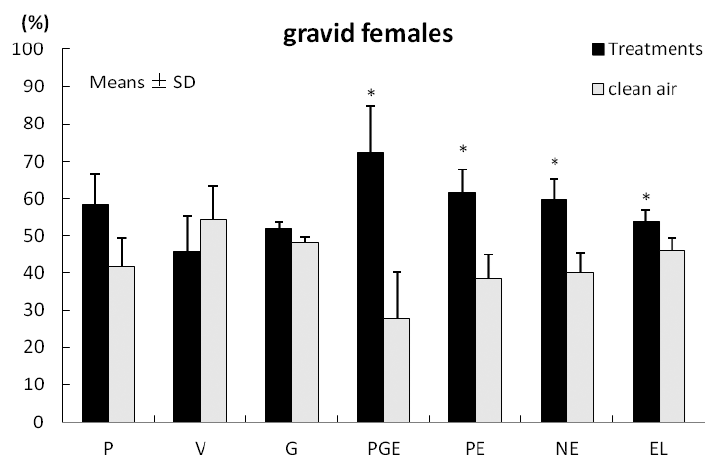
Figure 2. Trend rates of gravid females of Cephalcia chuxiongica to volatiles in one-way choice tests. P one pine shoot V one virgin female G one gravid female PGE one pine shoot with one female and her fresh eggs on the needles PE one pine shoot with fresh eggs but no female NE needles’ extract EL eggs’ eluent. *Indicates a statistically significant difference ( P < 0.05) between the trend rates of the gravid fe- males to the odor and to clean air (nonparametric Wilcoxon matched pairs test, two-tailed). shoot in which the ‘pioneer’ females had laid eggs (Figure 1). This affirmed our surmise that the delivery females of C. chuxiongica in pine shoots can attract more other con- specific gravid females to aggregate in the same pine shoot for